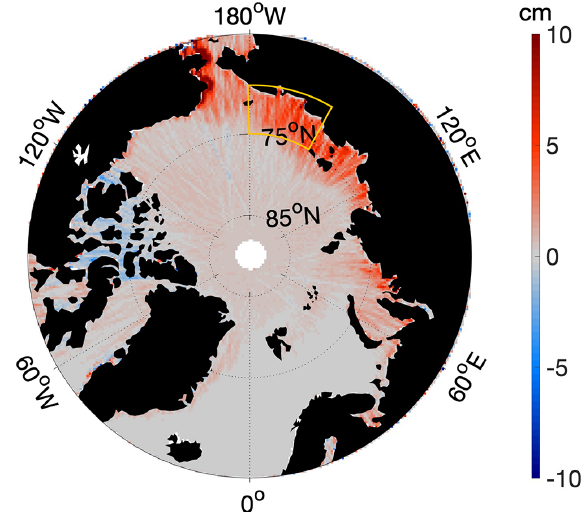
Figure B1. The along-track improvement in DAC correction, with respect to IB, in removing η (cid:48) high-frequency variability. Colors in- dicate the difference between the standard deviation of along-track η (cid:48) corrected with IB and corrected with DAC. The yellow square indicates the region of the East Siberian Sea where the frequency analysis was